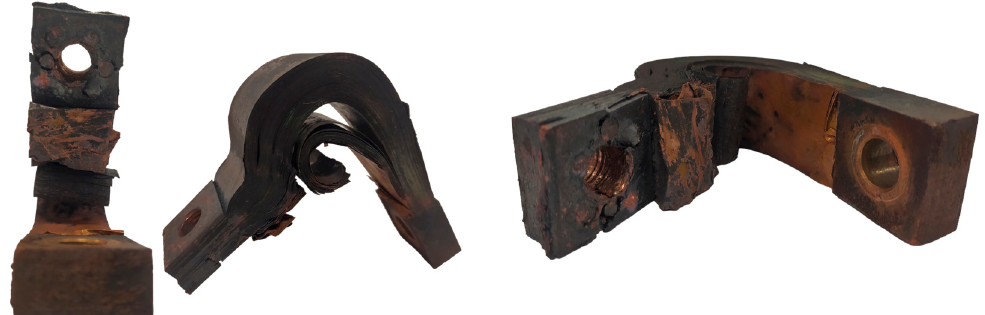
Figure 19. Real case of detection-worn copper strip. Cut